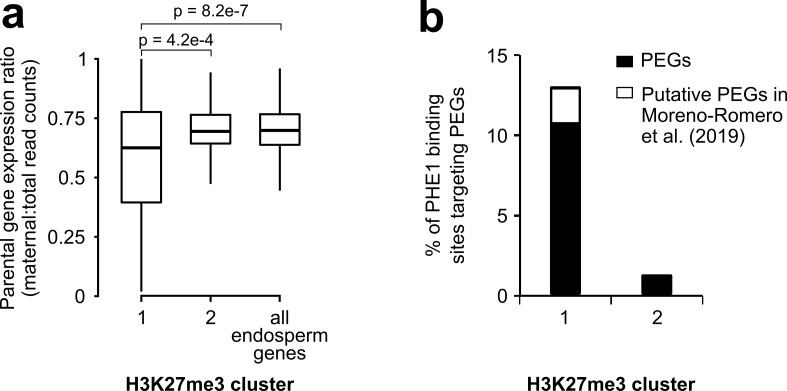
Characterization of H3K27me3 clusters.(a) Parental gene expression ratio of PHE1 targets associated with Cluster 1 and Cluster 2 binding sites, and all endosperm expressed genes. P-values were determined using two-tailed Mann-Whitney tests. (b) Fraction of Cluster 1 and Cluster 2 binding sites that target PEGs (Figure 4—source data 1) and putative PEGs (Moreno-Romero et al., 2019). (a, b) H3K27me3 clusters are those defined in Figure 4b.